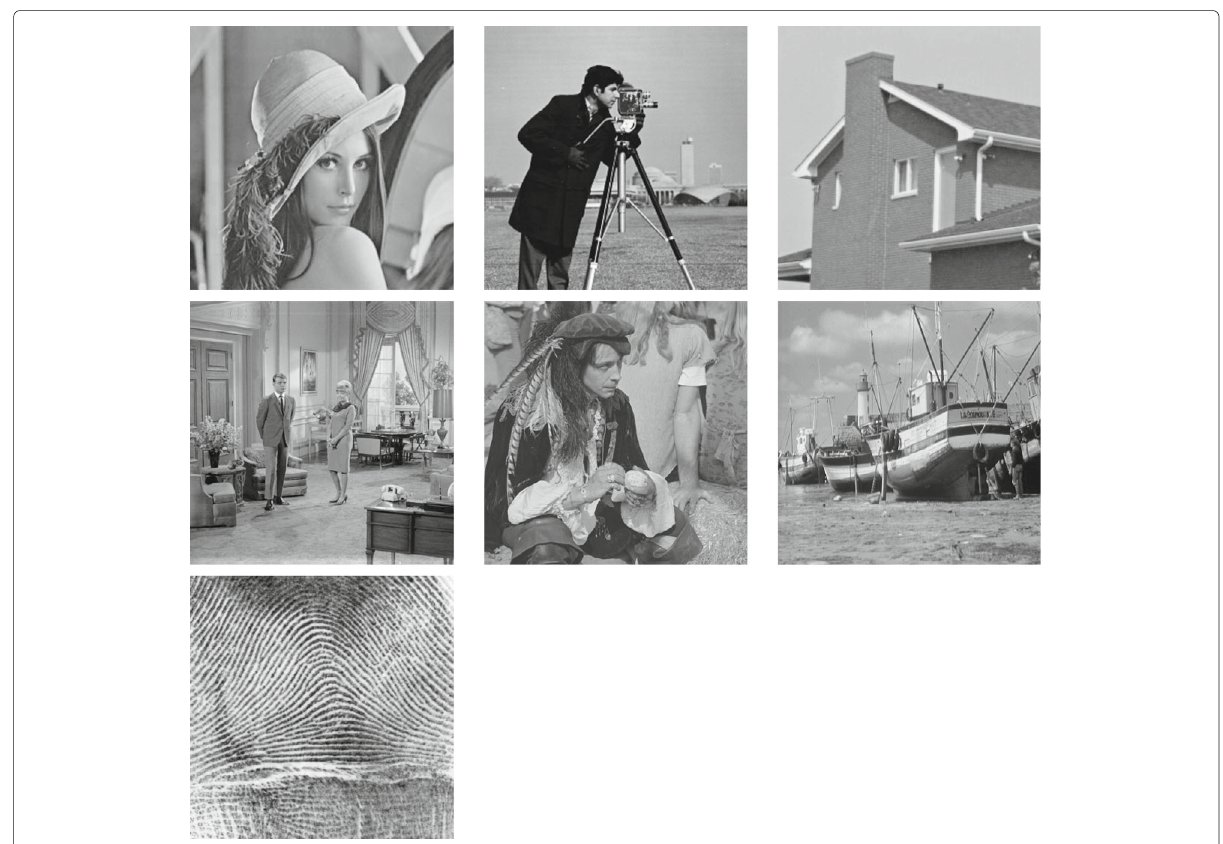
Fig. 2 Set of seven images used in the tests. This is a set of seven images used as an original image in the